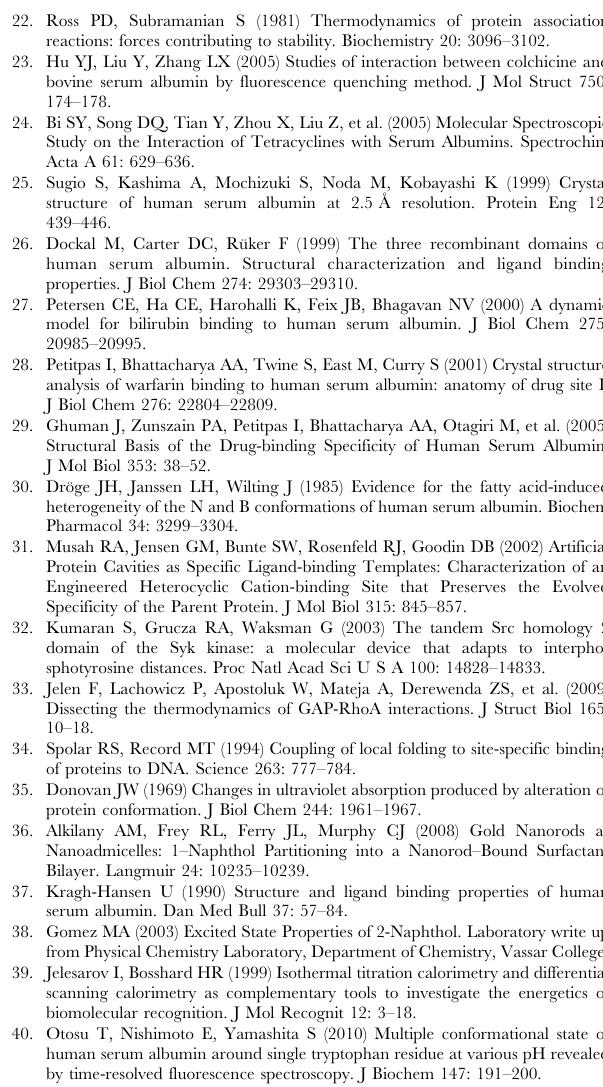
Table S1 Interaction profile of pollutants with HSA after flexible docking with Autodock where number of contacts for